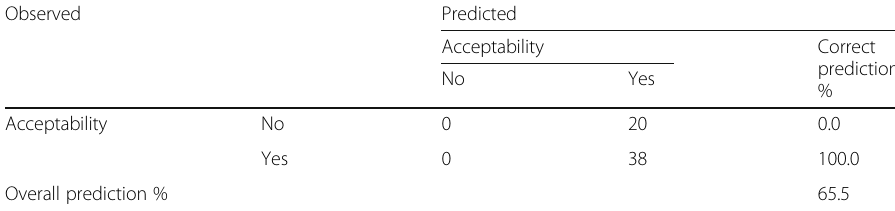
Table 8 Classification without the independent predictor Observed